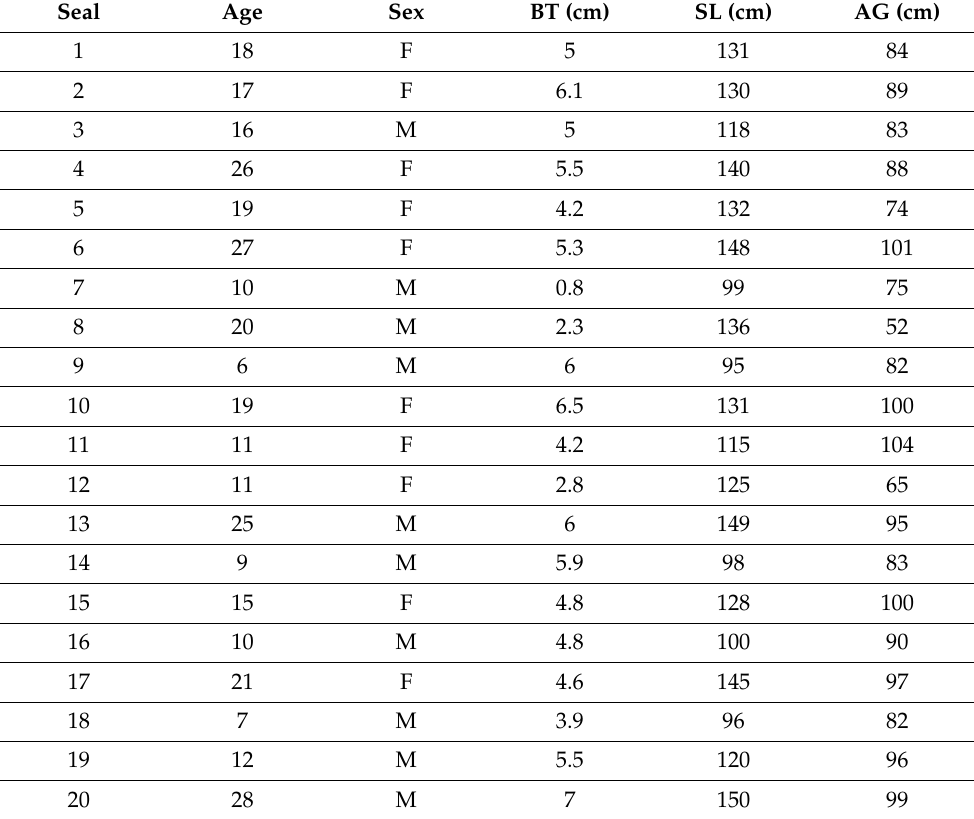
Table 2. Summary of samples collected from 20 deceased Caspian seals in Iran (2013–2016). The age of seals is also reported, as determined after Amano et al. [52]. BT: Blubber thickness; SL: Straight length; NTL: AG: Axillary